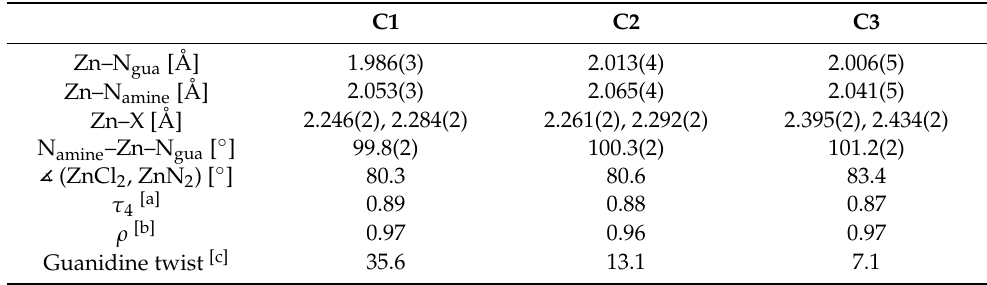
Table 1. Key bond lengths and angles of the zinc complexes C1 [Zn(TMGca)Cl 2 ], C2 [Zn(DMEGca)Cl 2 ], and C3 [Zn(DMEGca)Br 2 ].